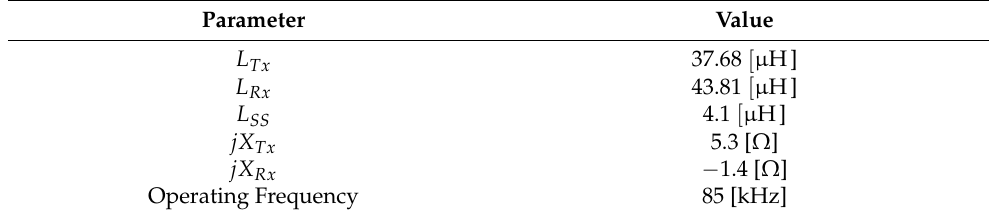
Figure 12. Impedance magnitude at the operating frequency according to the resonance frequency of the SS coil.